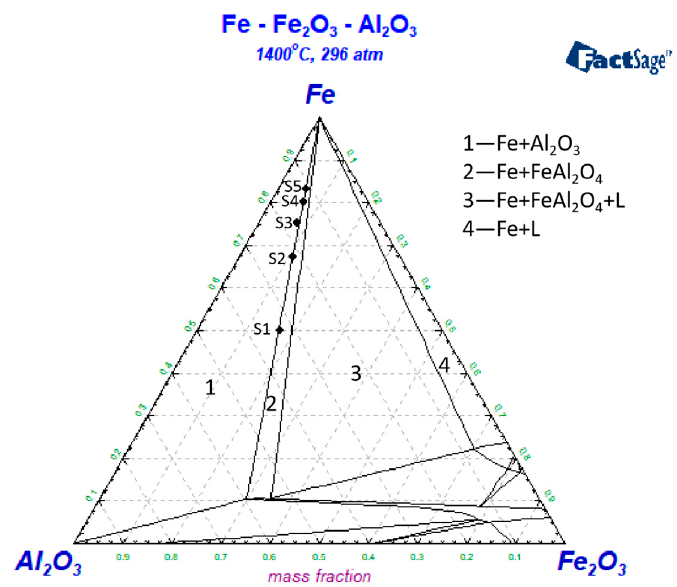
Figure 1. Fe-Fe 2 O 3 -Al 2 O 3 phase diagram at 1400 °C.